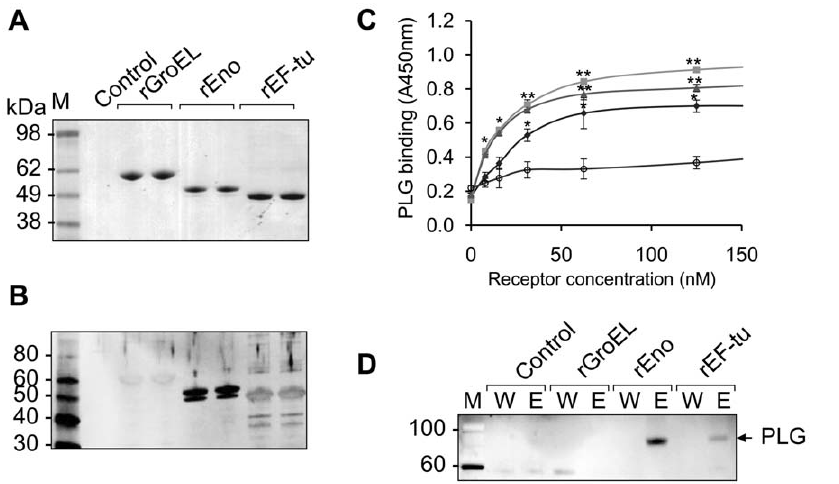
Figure 5. PLG binding of recombinant receptors. (A) Recombinant proteins were expressed on plasmid pTrcHis2-TOPO by IPTG induction and purified by Ni + -chelate column chromatography. The purified proteins were visualized on SDS-PAGE by Coomassie blue staining. (B) Analysis of PLG binding of recombinant receptors by ligand blot. The bound PLG was detected by anti-PLG antibody. (C) Analysis of PLG binding of recombinant N receptors by ELISA. Different concentrations of receptors were immobilized on a plate. After incubation with PLG (0.1 m g/well), binding activity was , GroEL; and # , control BSA. (D) PLG binding of receptor-conjugated beads. analyzed by anti-PLG antibody antibody. & , enolase; m , EF-tu; Receptor-conjugated beads (50 m l) were incubated with PLG (1 m g) and eluted with 100 m l of 3 M potassium thiocyanate. The eluted protein (10 m l) from the beads was analyzed by Western blotting with anti-PLG.